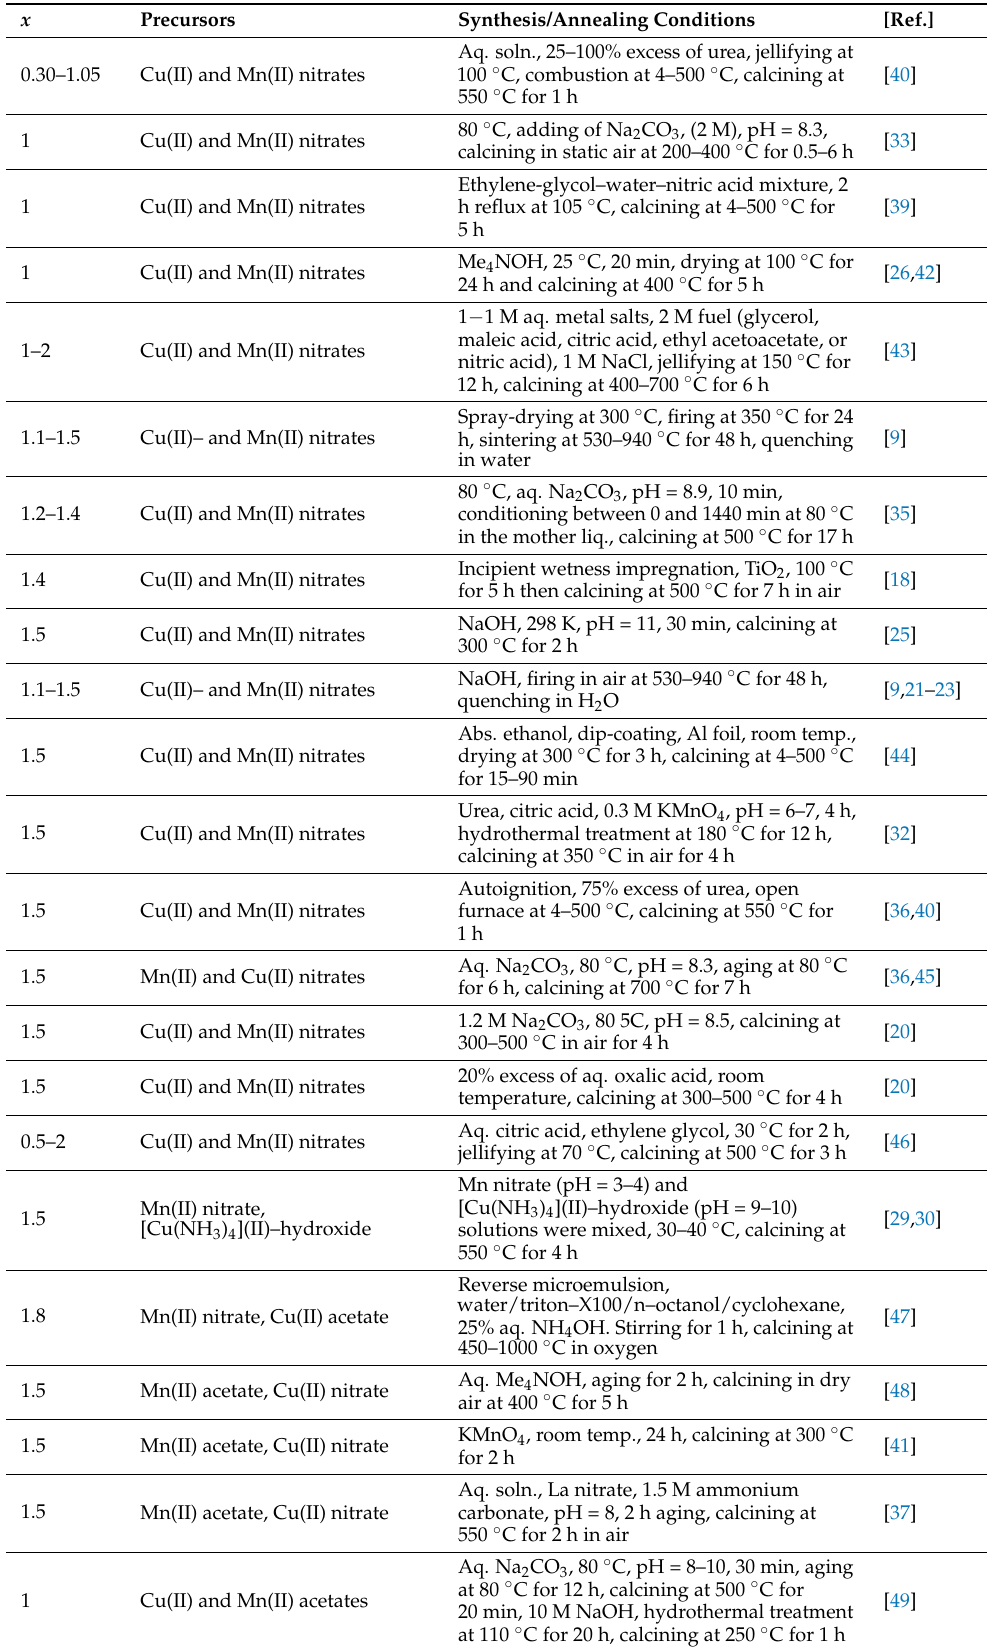
Table 2. Synthesis conditions of Cu x Mn 3 − x O 4 catalyst with solution-phase